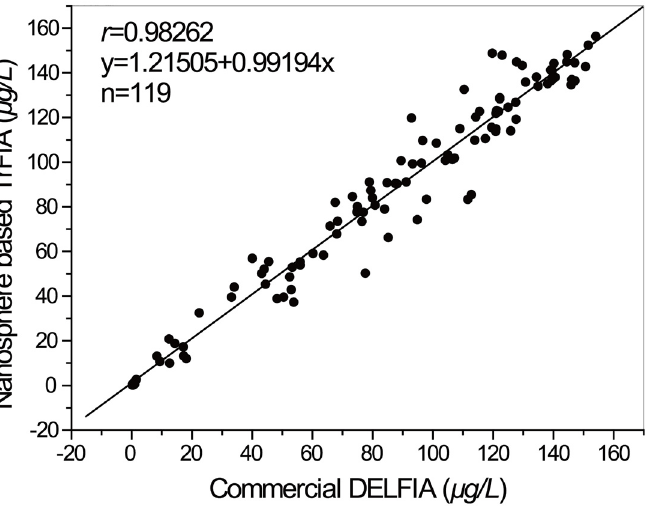
Fig 11. Regression analysis result of BC-EDTA/Eu 3+ -nanosphere based TrFIA and DELFIA.